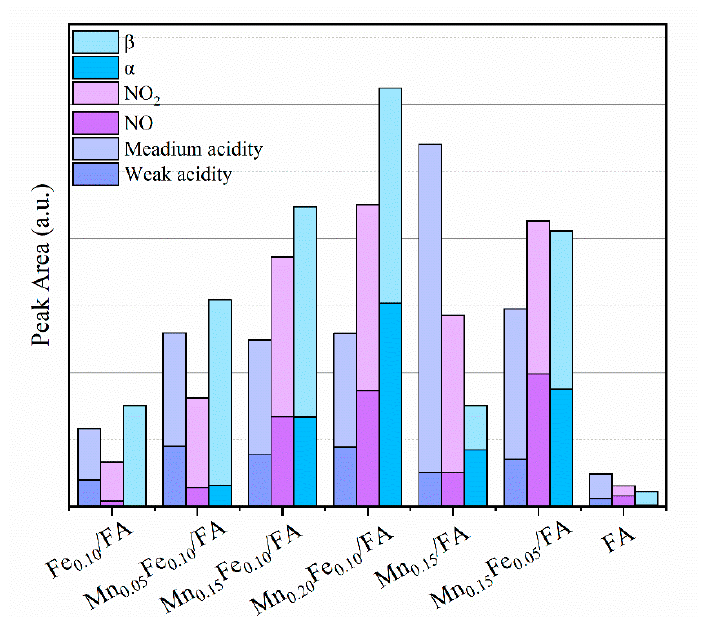
Figure 3. The peak area of NO/NH 3 -TPD and H 2 -TPR on different catalysts.